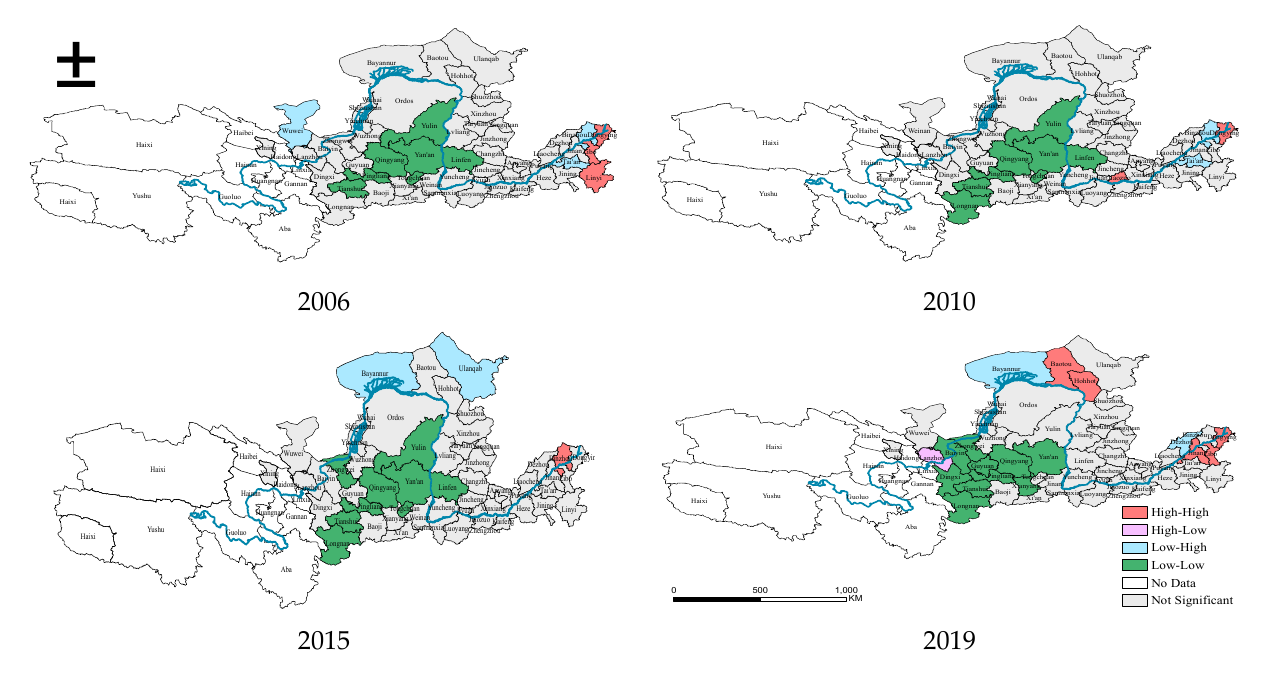
Figure 1. Spatial clustering of carbon emissions.